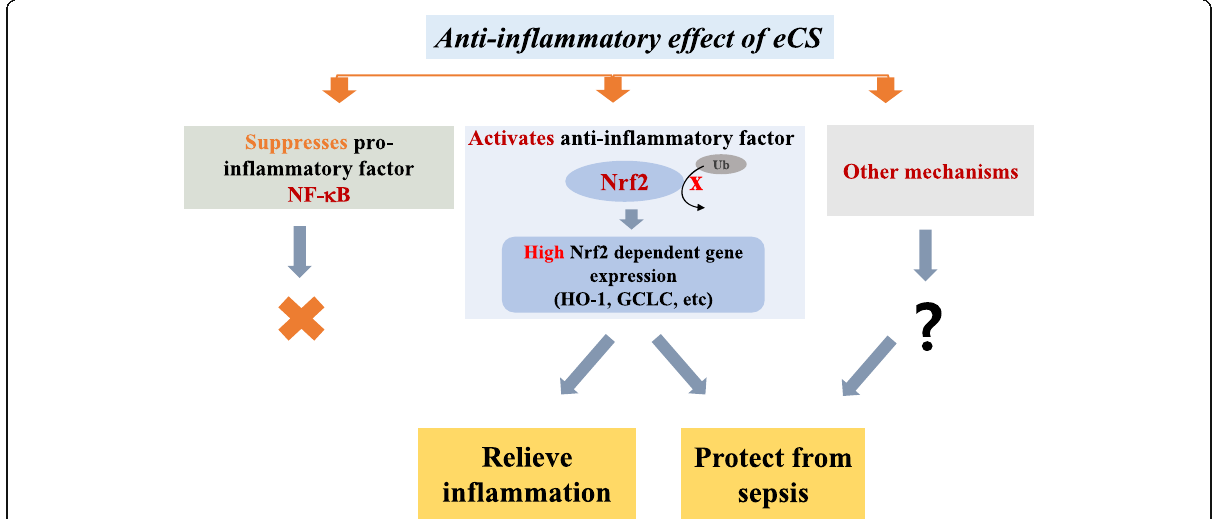
Fig. 9 Schematic mechanisms of eCS in suppressing inflammation. The anti-inflammatory activity of eCS could be achieved by suppressing a pro- inflammatory factor, NF- κ B, and/or activating an anti-inflammatory factor, Nrf2. In our experimental setting, eCS activated Nrf2, while seemingly not suppressing NF- κ B. Alternative pathways are likely and need to be explored. Regardless of mechanisms in detail, eCS effectively suppressed acute and severe lung inflammations in